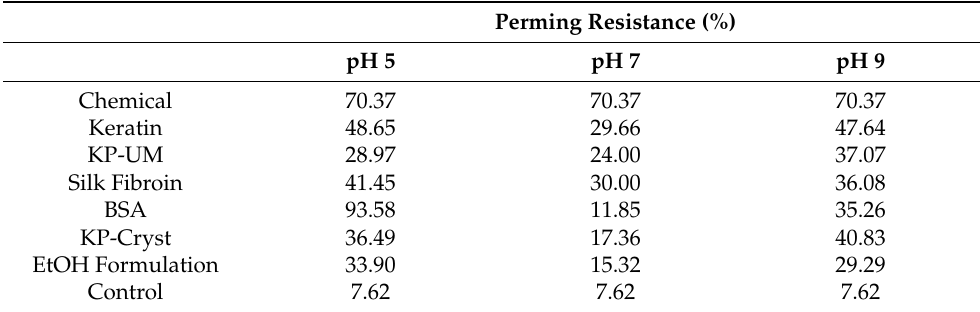
Table 3. Hair perming resistance to washing. The resistance values were obtained by comparing the perming efficiencies after six wash cycles with the perming efficiencies before any wash step. Perming Resistance